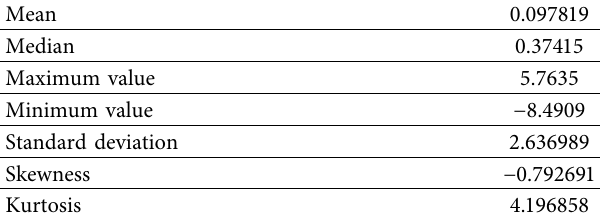
Table 1: Descriptive statistics of A-share returns.